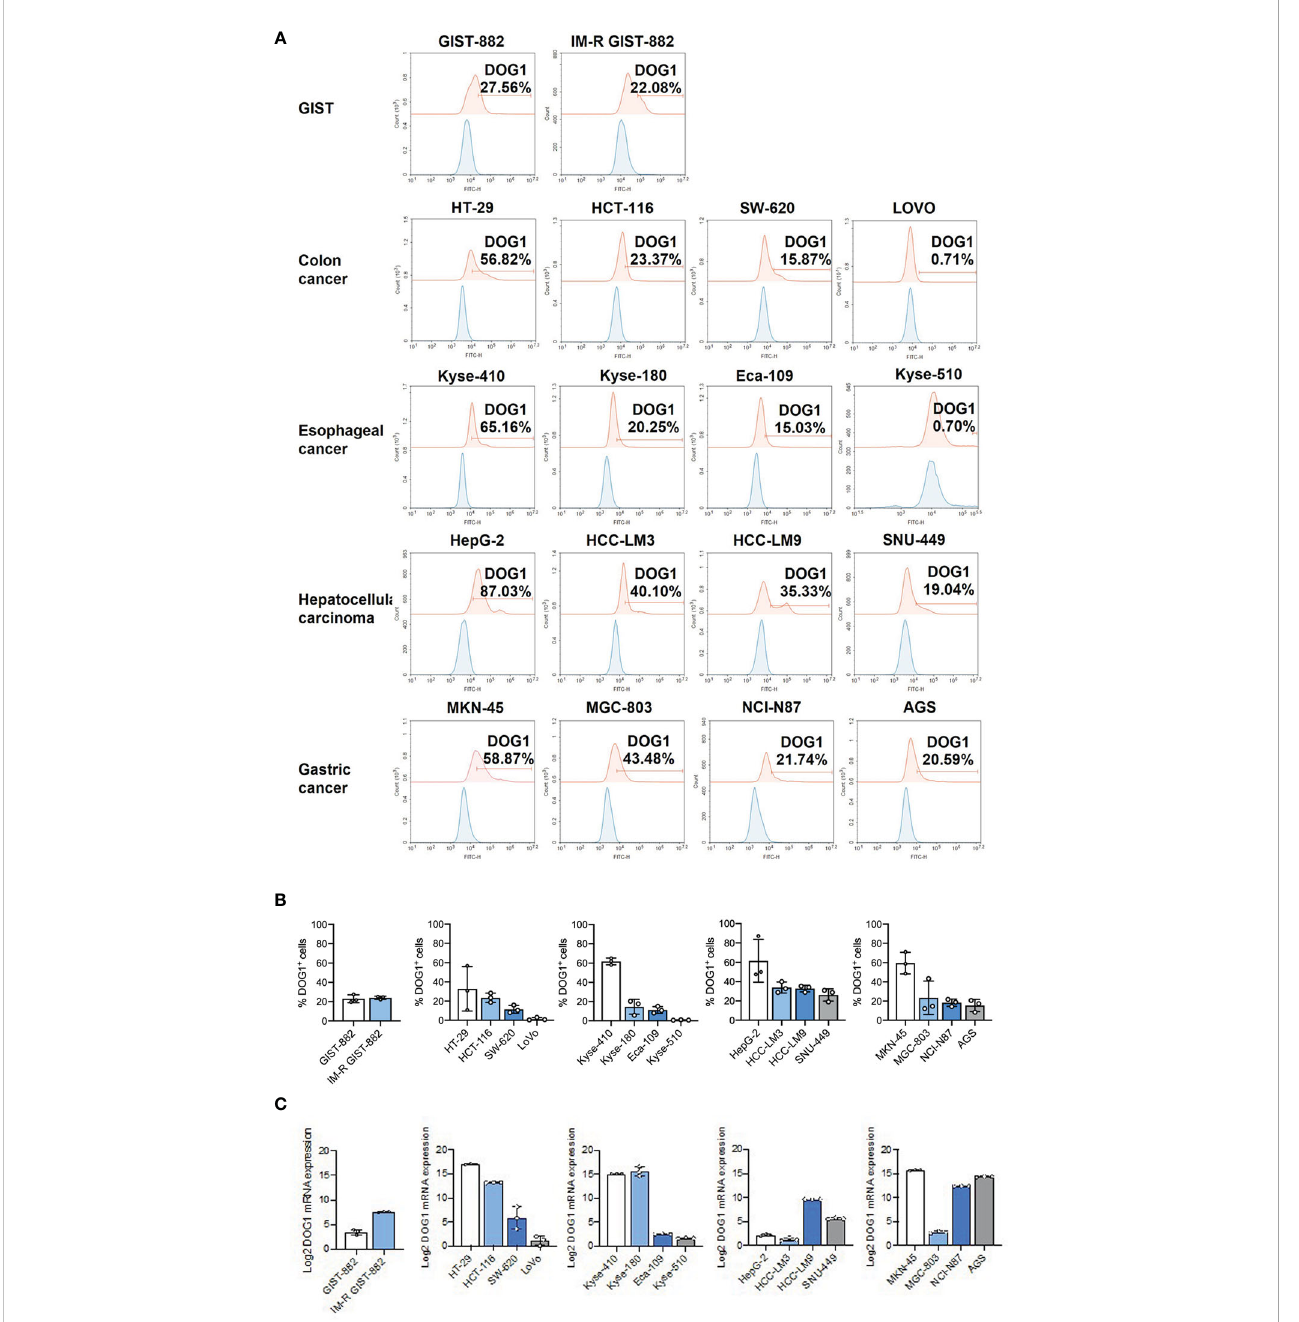
FIGURE 2 DOG1 was expressed on the cell surface. (A) Representative graphs of DOG1 surface expression analyzed by fl ow cytometry. Blue is the isotype control group, and red is the anti-DOG1 antibody group; (B) Flow cytometric detection of DOG1 protein expression on the surface in various tumor cell lines, including GIST cells and colon, esophageal, liver and gastric cancer cells. Three independent experiments were performed; (C) DOG1 mRNA expression in various tumor cell lines, including GIST cells and colon, esophageal, liver and gastric cancer cells, were detected by qPCR. Three independent experiments were